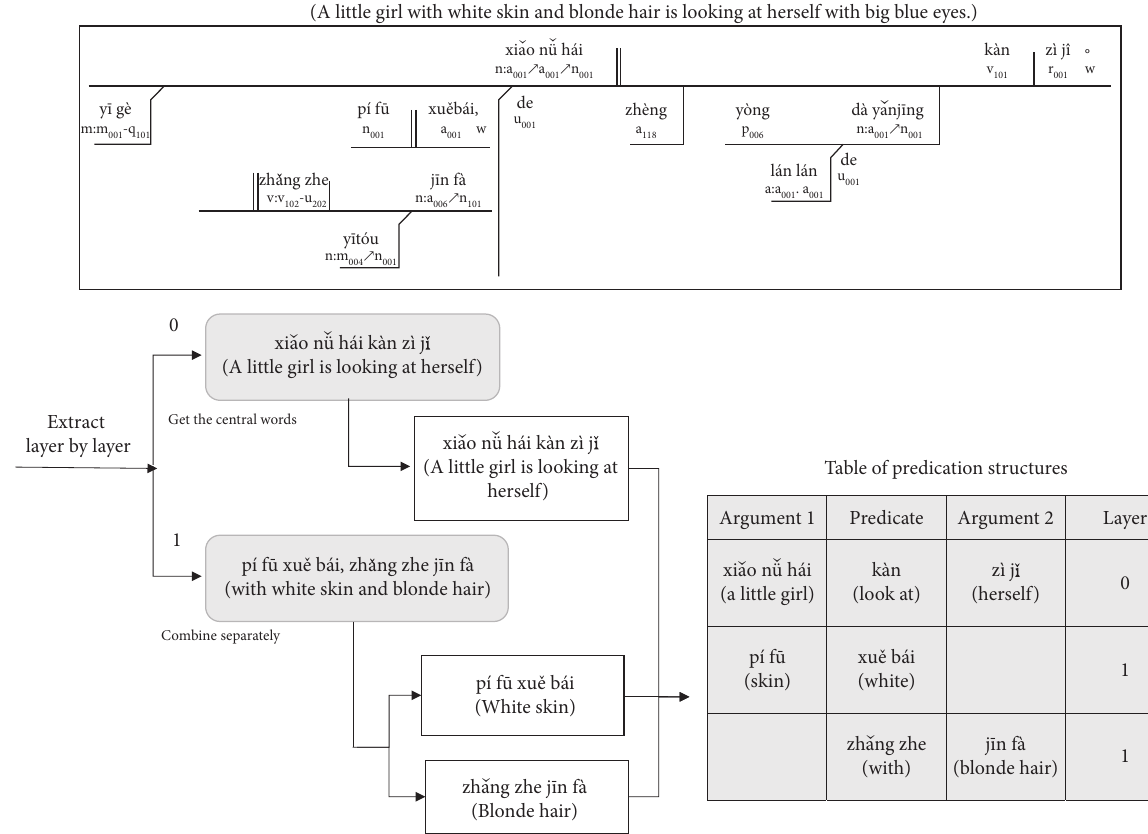
Figure 2: The extraction of predication